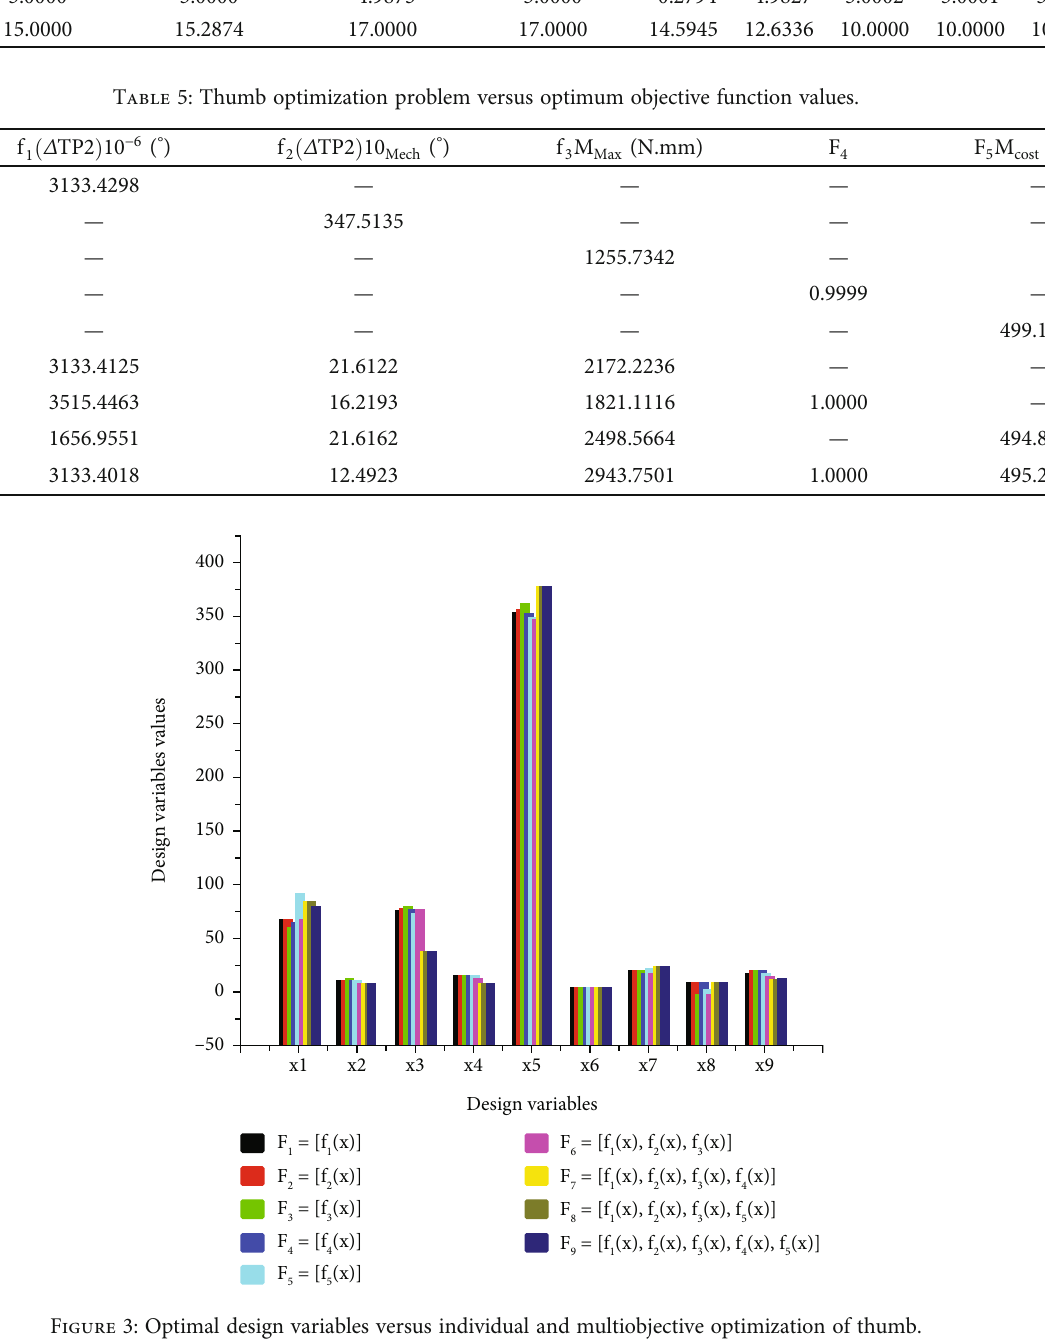
Figure 3: Optimal design variables versus individual and multiobjective optimization of